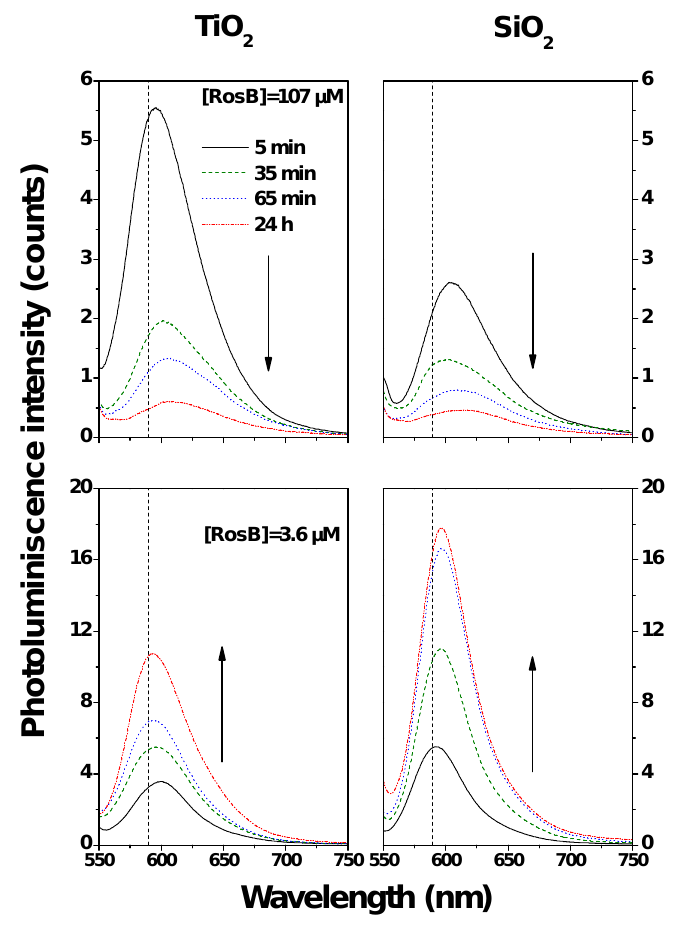
Figure 6. Photoluminescence spectra for composite RosB/MO 2 thin films prepared by infiltration of dichloromethane solutions at the highest and lowest concentrations considered at different infiltration